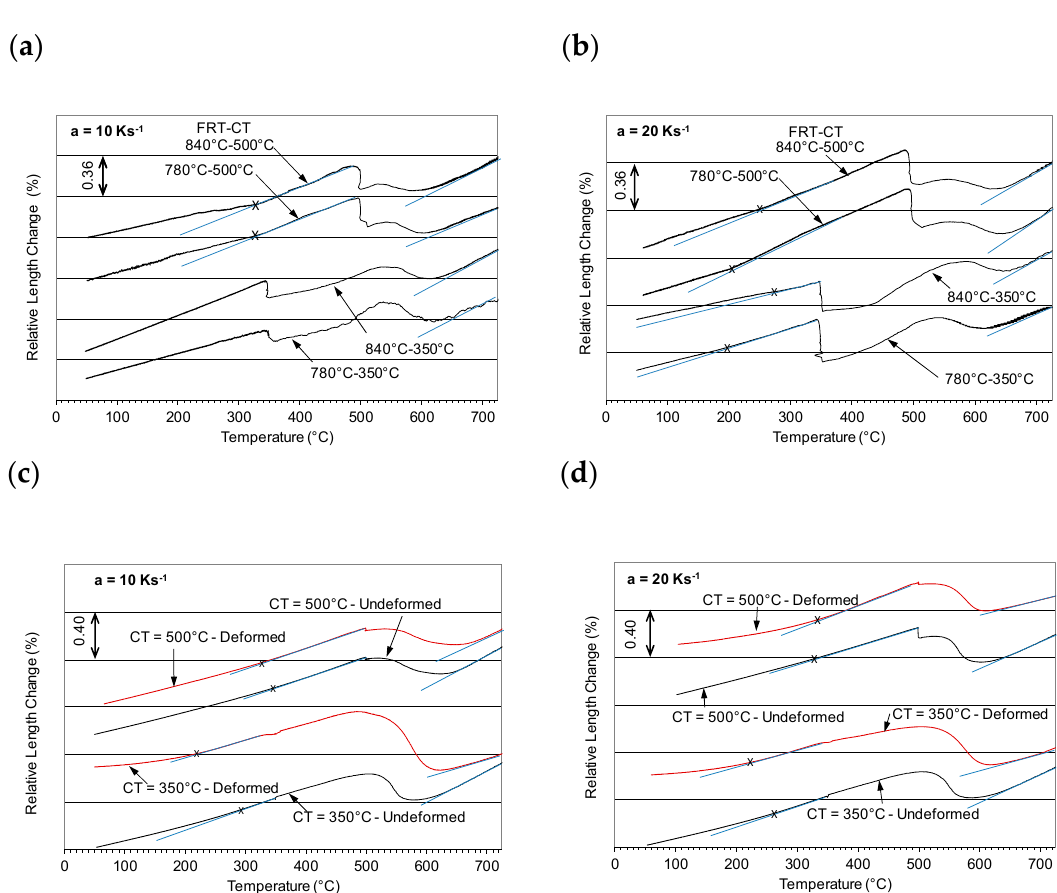
Figure 9. ( a , b ) Dilatation curves during continuous cooling of samples processed under the prescribed conditions. ( c , d ) Dilatation curves observed using Dil 805A/D for undeformed samples and deformed samples according to the TMP with FRT = 840 °C.